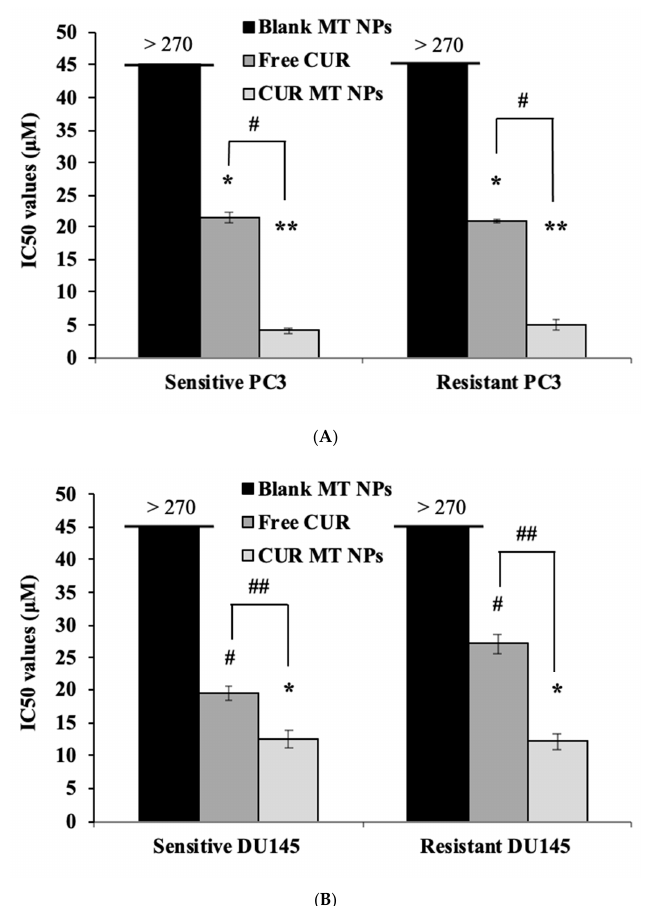
Figure 7. Comparison of IC50s for CUR, CUR MT NPs, and blank MT NPs in CRPC cells. ( A ) IC50 values (µM) of free CUR and CUR MT NPS in DTX-sensitive and -resistant PC3 cells. ( B ) IC50 values (µM) of free CUR and CUR MT NPS in DTX-sensitive and -resistant DU145 cells. Data are presented at the mean of three independent measurements ( n = 3) ± SD. #, ## p < 0.05 within the compared treatments; *, ** p > 0.05 within the compared treatments.